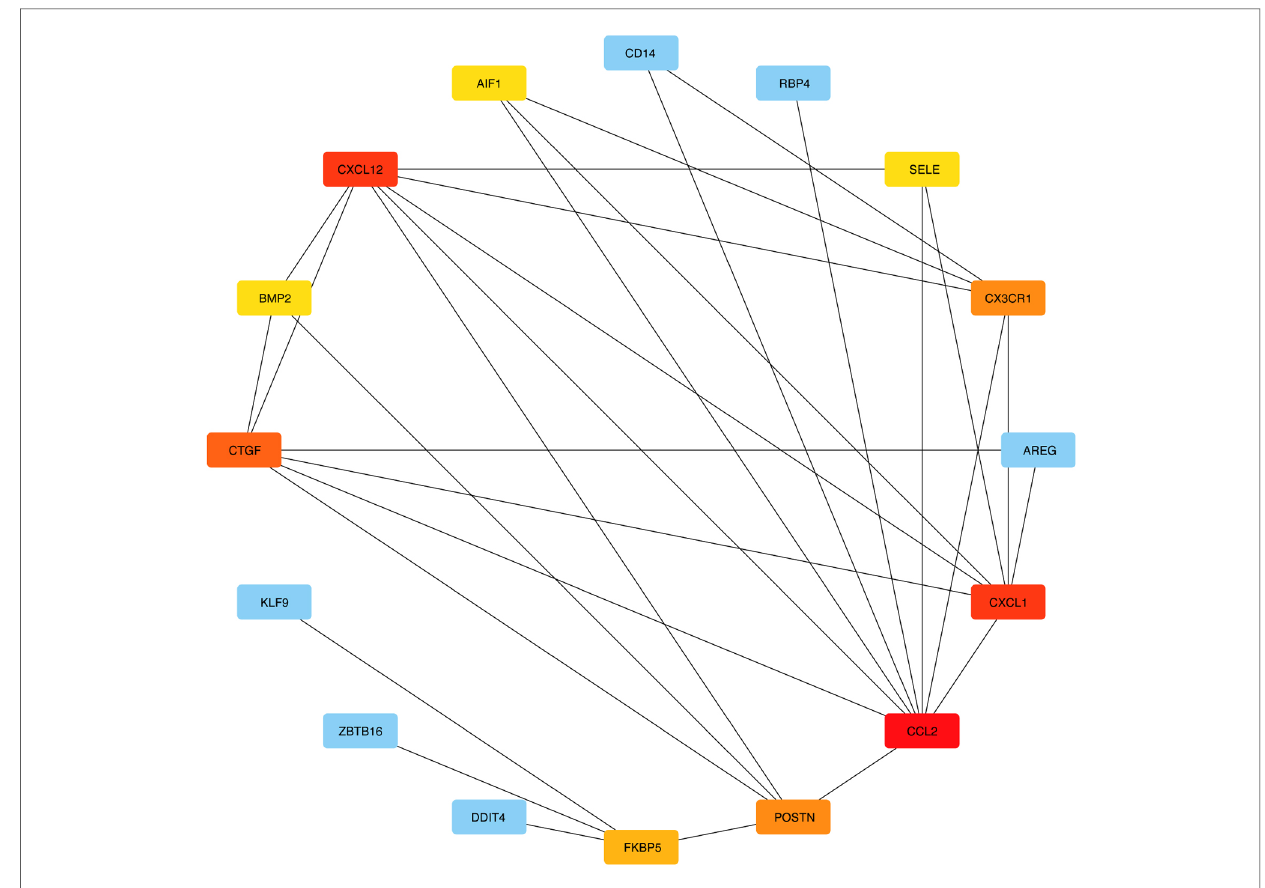
FIGURE 6 Network of differentially expressed genes created by Cytoscape.